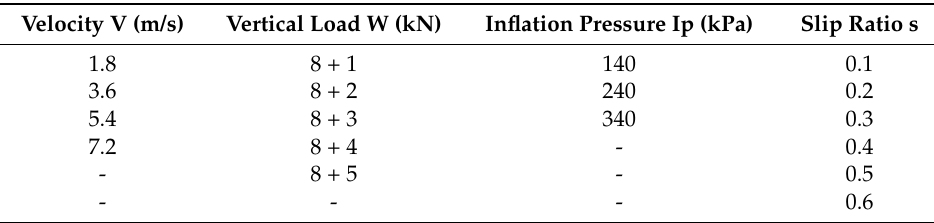
Table 1. Summary of the adopted levels of various